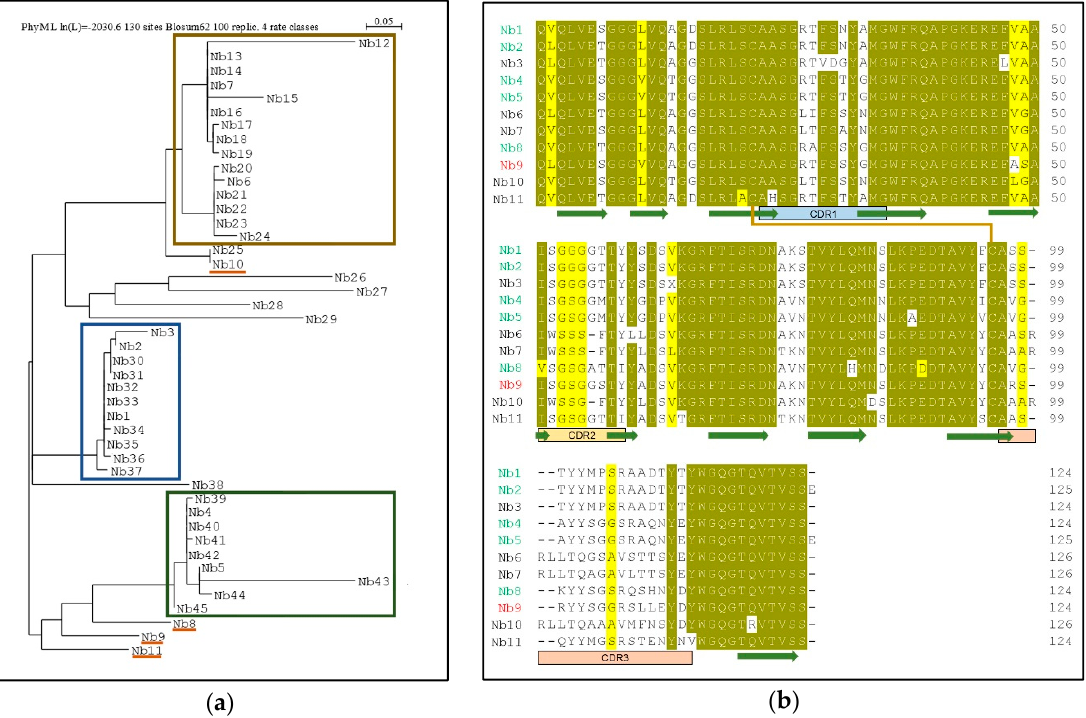
Figure 4. Sequence analysis of the identified Nbs . ( a ) Phylogenetic tree of 45 Nb sequences: The three main families of Nbs are highlighted by colored boxes: The first family (blue box) includes Nb1-2-3, the second family (green) includes Nb4-5, the third family (ochre) is composed of two subfamilies, which include Nb6 and Nb7, while Nb8-9-10-11 were sampled as outliers. ( b ) Sequence alignment of the 11 selected Nbs containing the predicted secondary structure ( β -sheets are shown as green arrows), the complementarity-determining regions (CDR1 to 3), and the conserved disulphide bond (orange line). Identical (90% threshold) residues are in dark yellow while similar amino acids in light yellow. Nbs that bind to SsZntA, but do not inhibit activity, are represented with a green name (Nb1-2-4-5-8), while in red, the Nb that significantly inhibits ATPase activity (Nb9). The Nbs that precipitated during purification (Nb3) or that caused precipitation of SsZntA (Nb6-7-10-11) are represented in black.